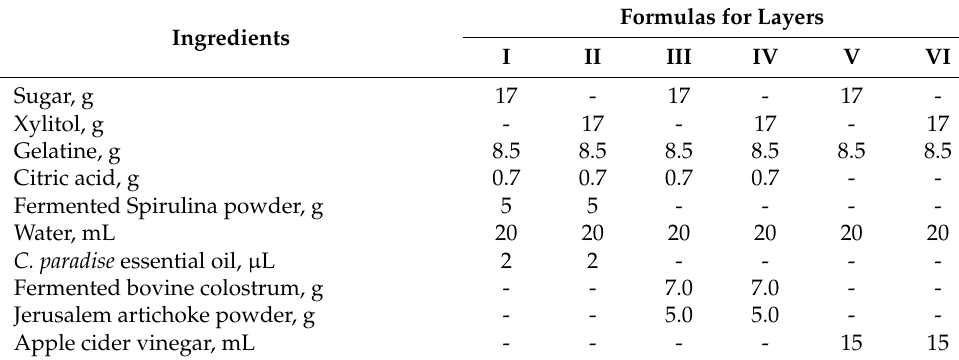
Table 1. Formulas for the layers of